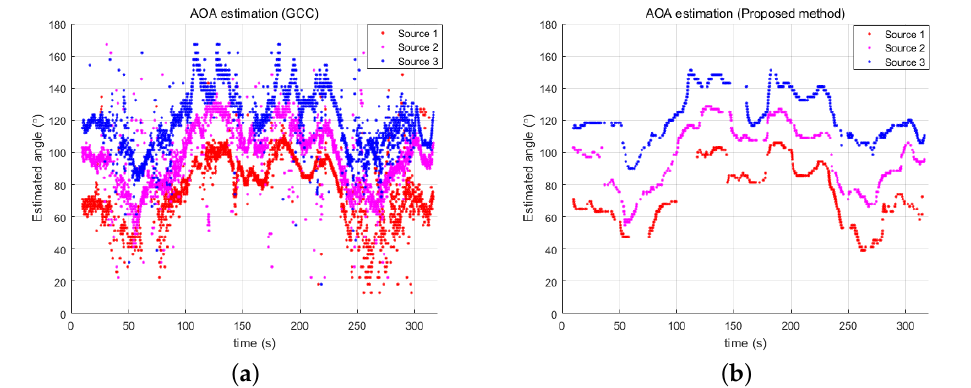
Figure 8. Estimated directional angles of three acoustic sources by: ( a ) GCC; and ( b ) the proposed